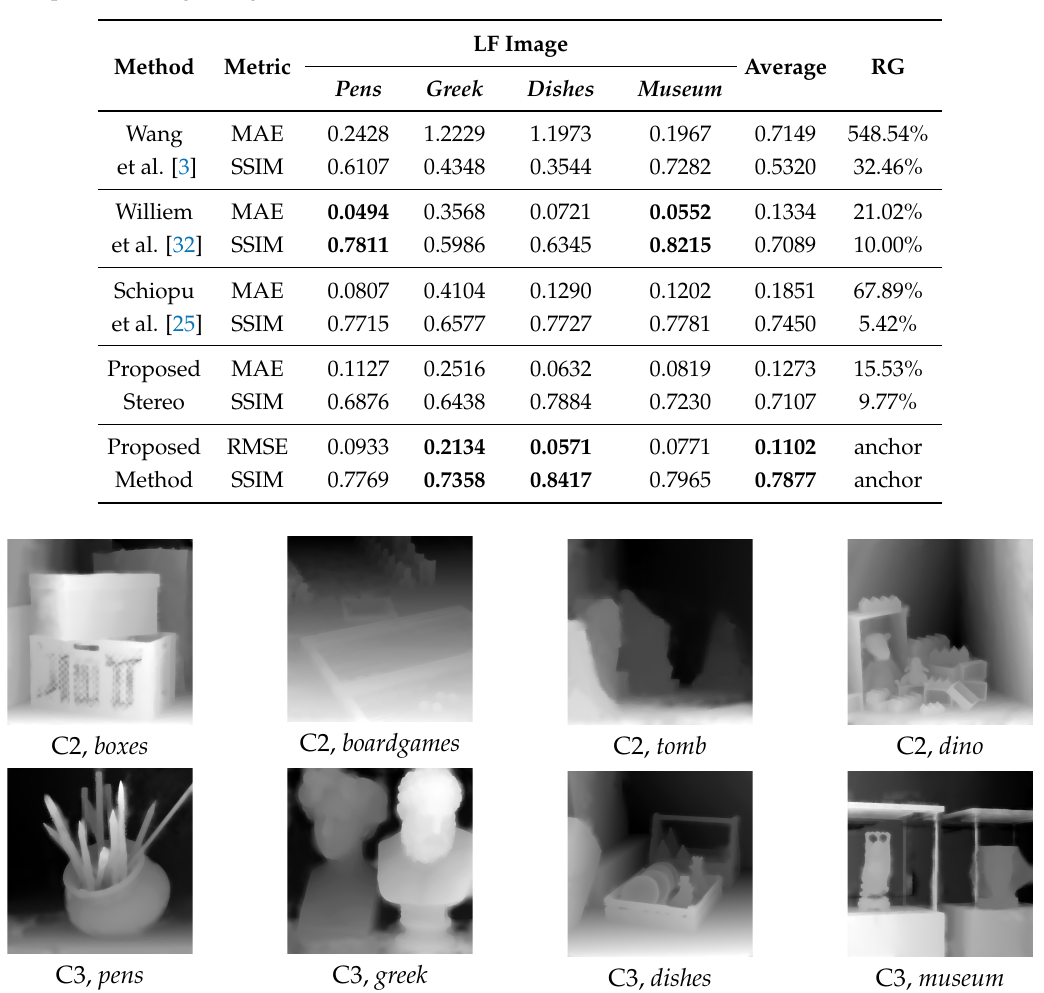
Table 3. Qualitative comparison in MAE and SSIM between computed and ground truth disparity maps for training configuration C3 of [25].